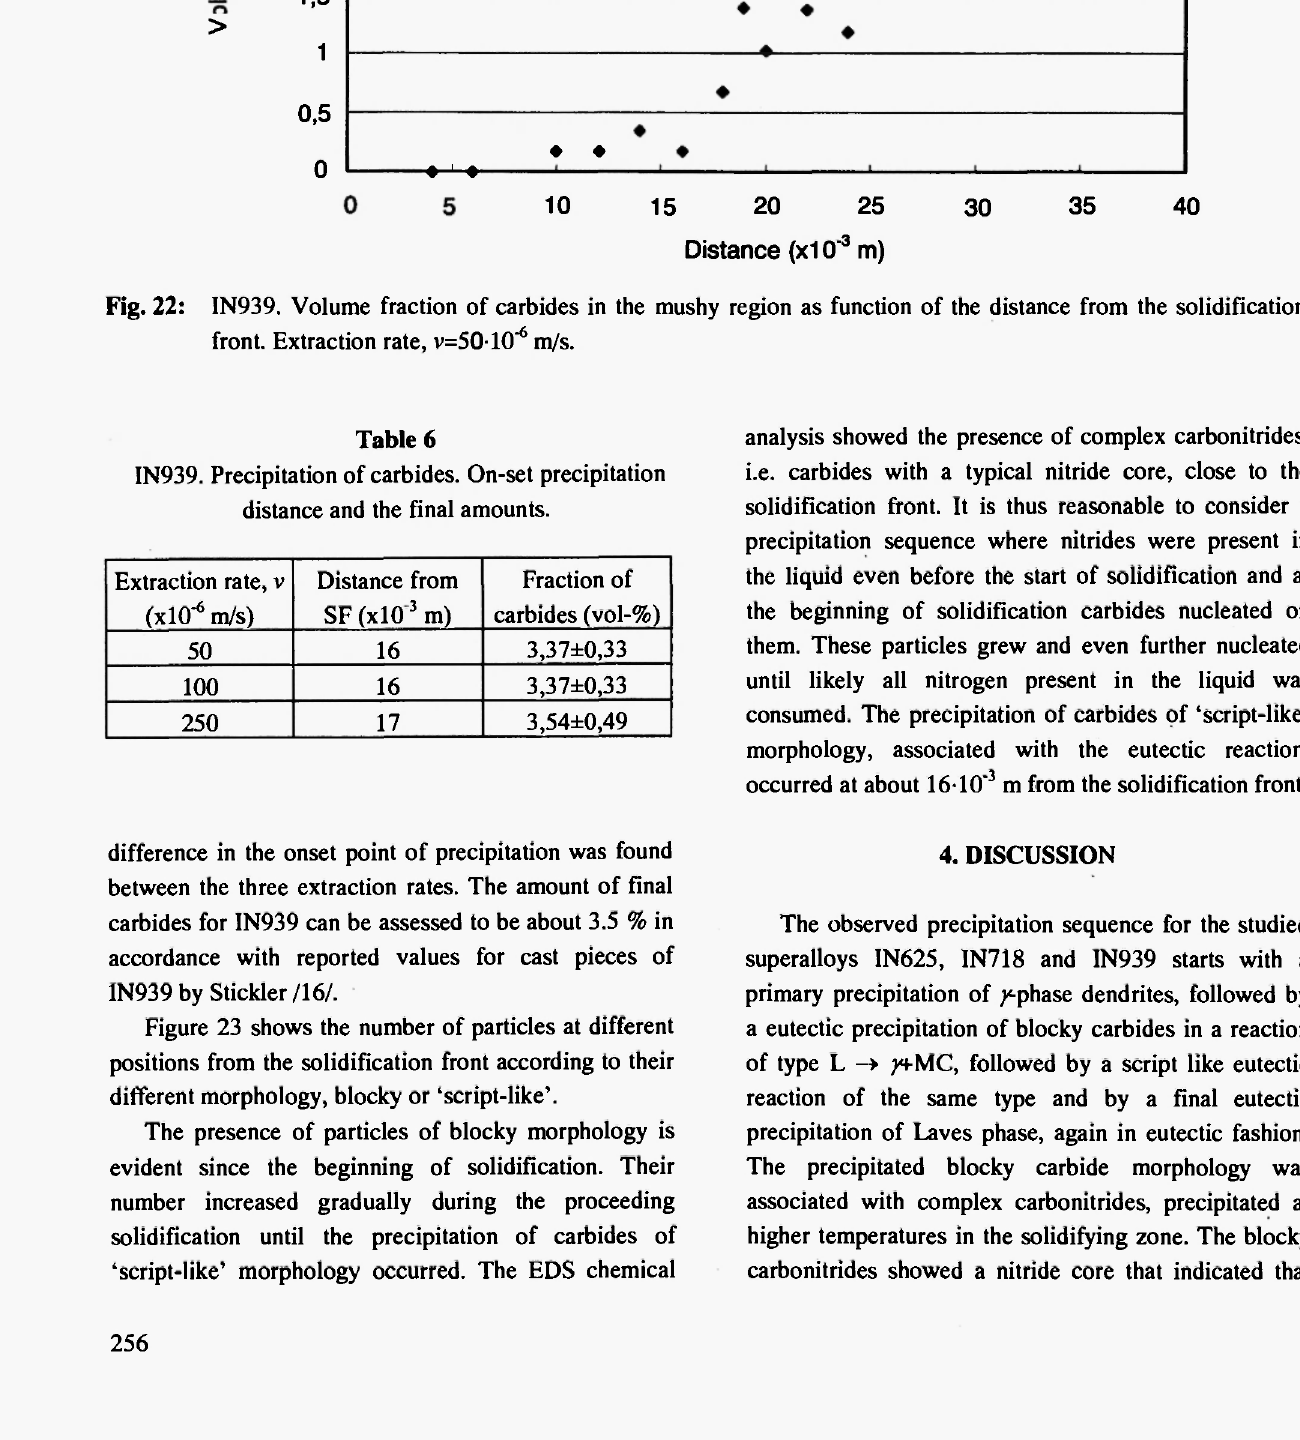
IN939. Volume fraction of carbides in the mushy region as function of the distance from the solidification front. Extraction rate, v= 50T0* 6 m/s.